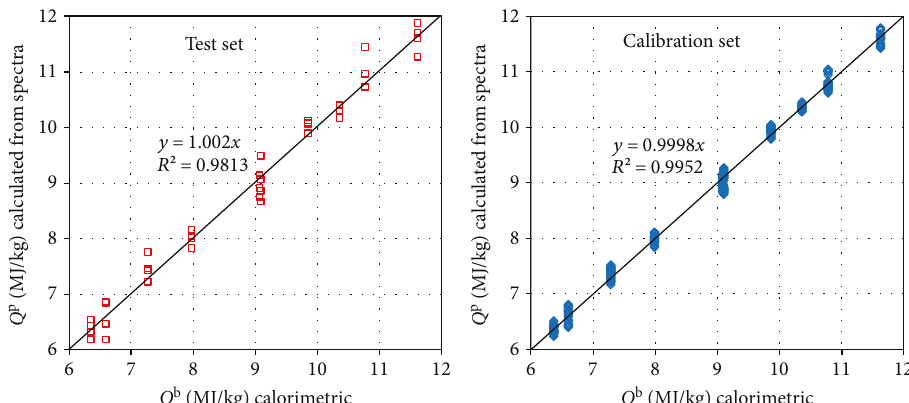
Figure 6: Heating value of oil shale Q p determined by LIBS versus calorimetric heating value Q b . Solid lines are linear fi ts for data points, whereby the intercept is set to zero.